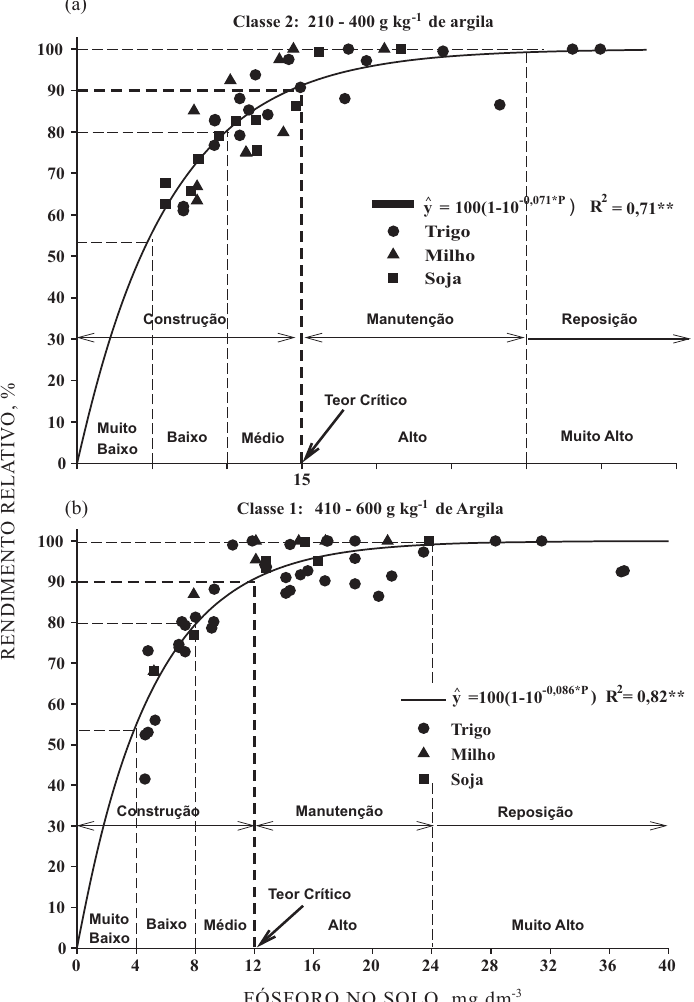
Figura 2. Teor crítico de fósforo disponível no solo na profundidade de 0–0,10 m, determinado por Mehlich- 1, na média de rendimentos de trigo, milho e soja sob sistema plantio direto (a) classe textural 2 (experimentos Misiones 1, Misiones 2 e Alto Paraná 1) e (b) classe textural 1 (experimentos Itapúa 1, Alto Paraná 2 e Pedro Juan Caballero 1). ** Significativo (p <